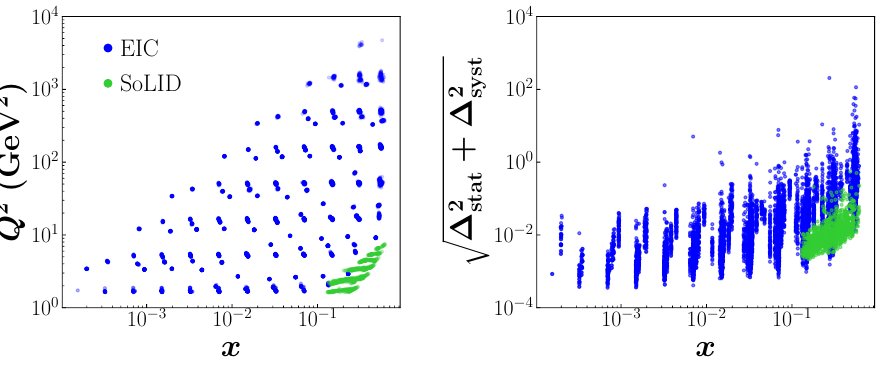
Figure 2: (Left) Scatter plot of the x and Q 2 coverage of the EIC (blue points) and SoLID (green points). (Right) The quadrature of statistical ( ∆ ( ∆ ) errors of the pseudo-data for the Collins effect in SIDIS plotted versus x syst